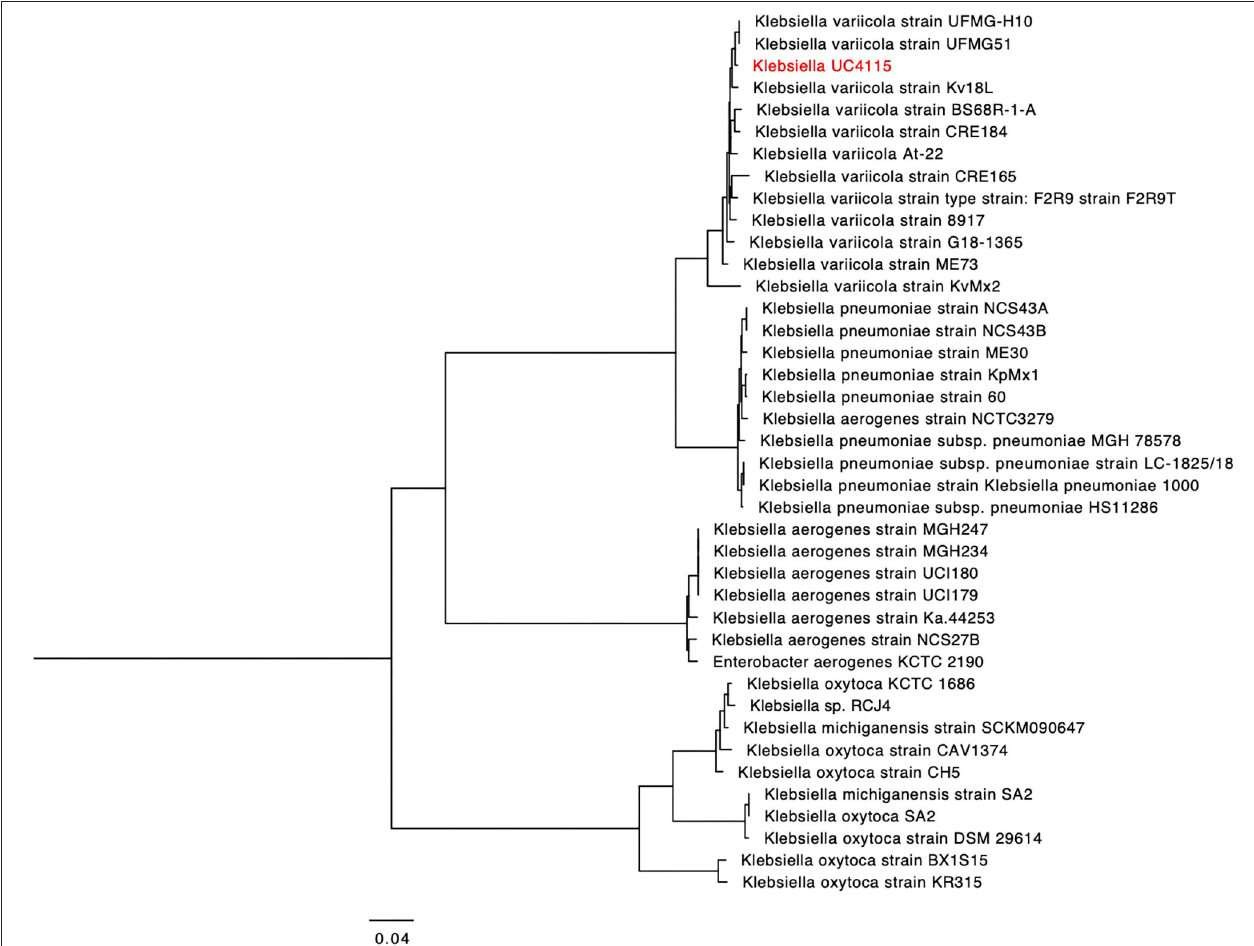
FIGURE 1 | Phylogeny of K. variicola UC4115 based on the analysis of PGFams.